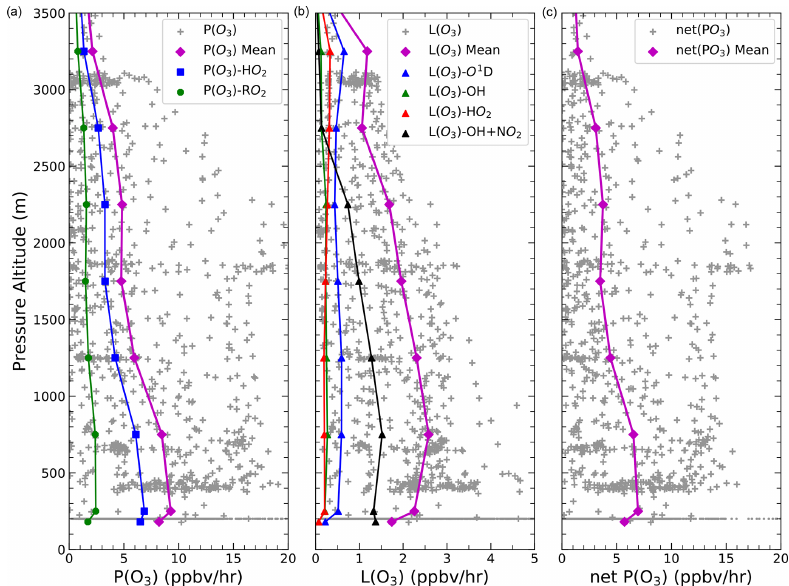
Figure 9. Vertical profiles of the rate of production of O 3 (a) , O 3 loss rate (b) , and net O 3 production rate (c) during